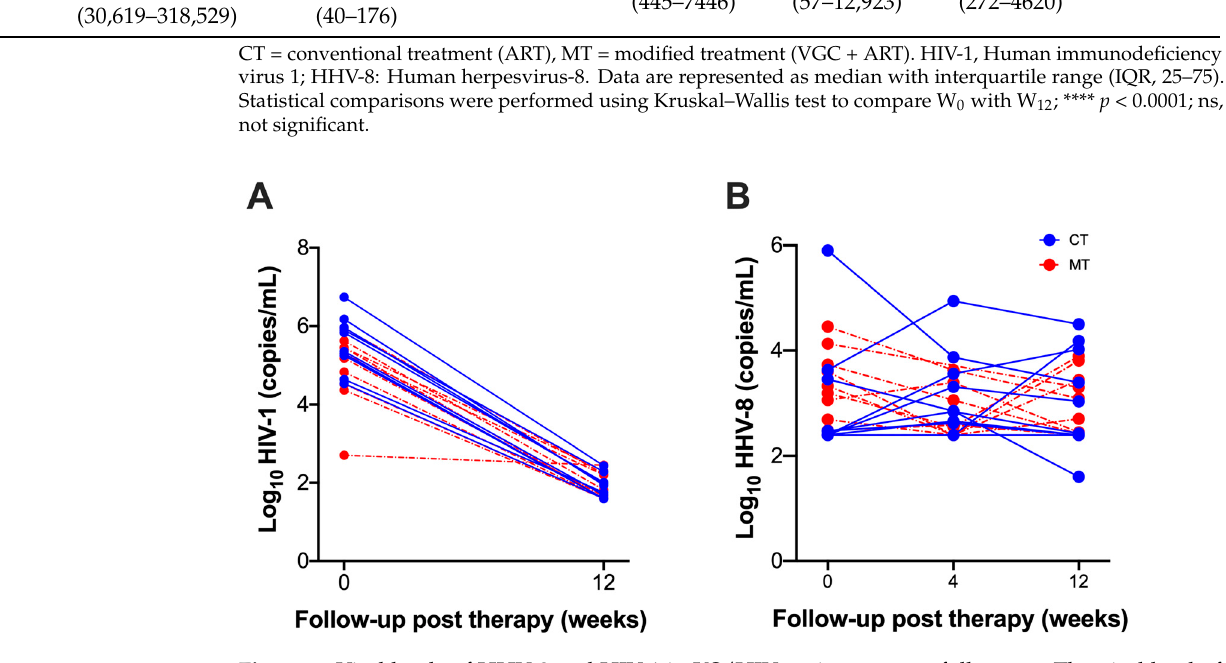
Figure 4. High circulating IL-15 levels at baseline in KS/HIV patients decreased after treatment. IL- 15 levels were compared at the baseline (W 0 ) between KS/HIV and HIV+ patients and across all follow-up weeks between each group. The black dashed line represents the median value of HIV- negative men. Green dots represent HIV+ asymptomatic men, blue dots represent CT and red MT participants. Statistical comparisons were performed using Kruskal–Wallis test, * p < 0.05, ** p < 0.01.